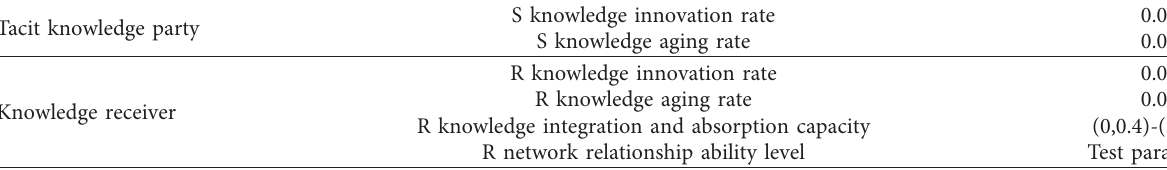
Table 1: Control table of policy parameters.